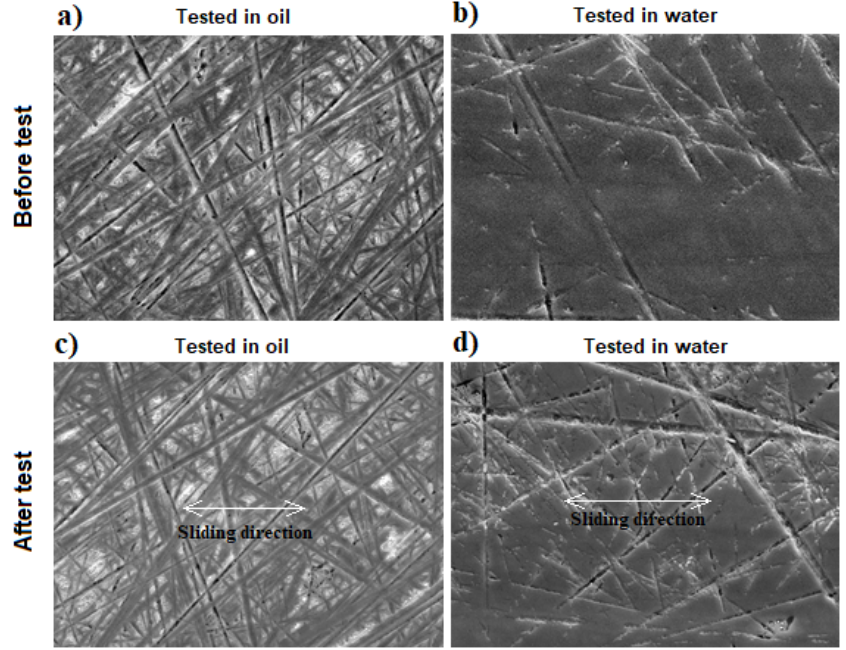
Figure 11. Scanning electron microscope (SEM) image of the DLC-coated disc ( a ) before test in oil, ( b ) before test in water, ( c ) after test in oil, ( d ) after test in water.